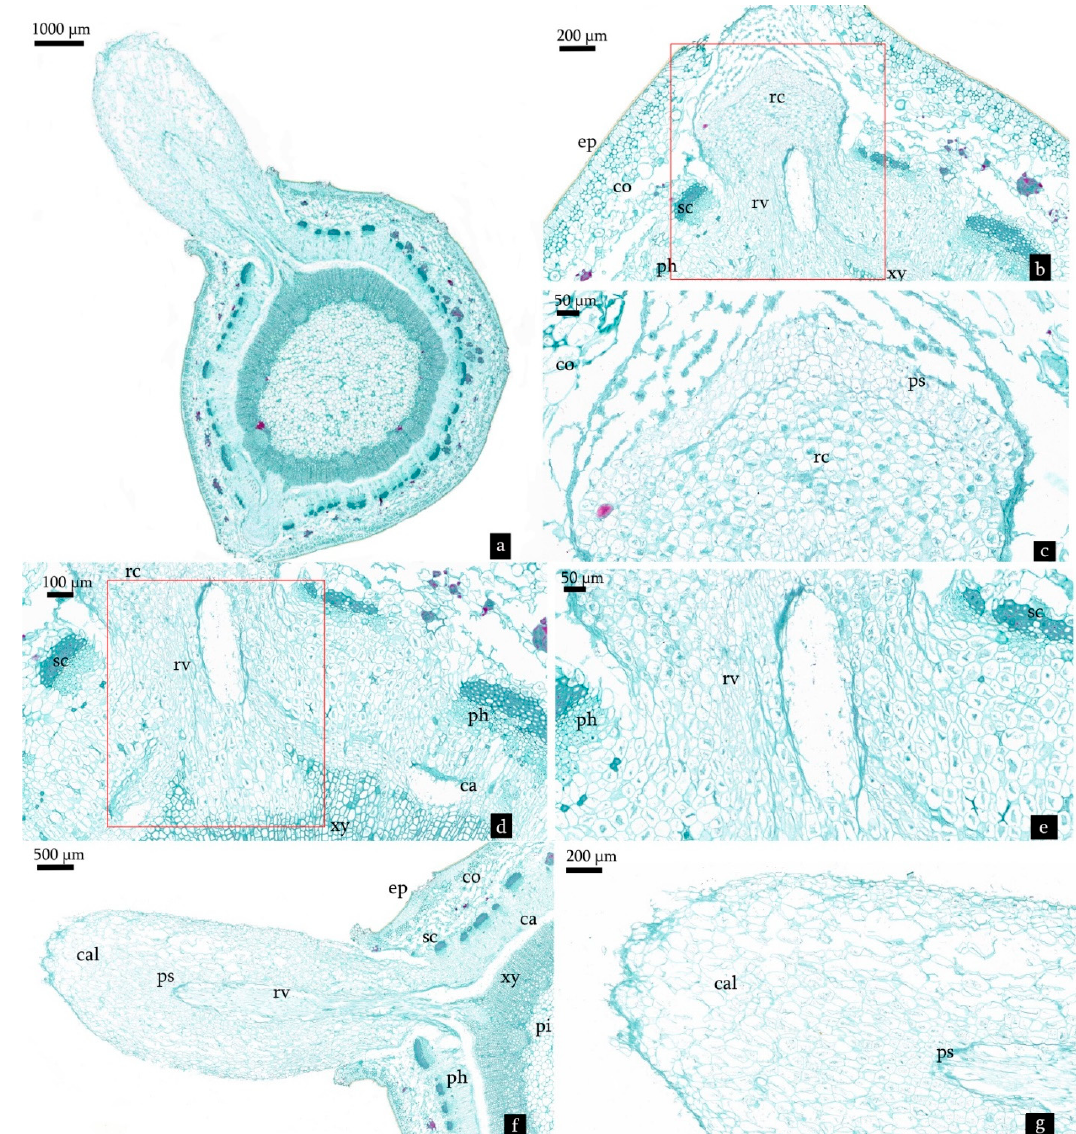
Figure 8. Transverse sections derived from cuttings treated with NAA:IBA (2:1) on the 28th day after planting. ( a ) Histological structure of cuttings treated with NAA:IBA (2:1) on the 28th day after planting. ( b ) Root primordia which achieved differentiation pushing into the cortex through the sclerenchyma of the cuttings. Red frame shows the adventitious root. ( c ) Root cap of the adventitious roots. ( d , e ) Root vascular bundles connected with the stem. Red frame shows the root vascular. ( f ) The adventitious root penetrated through cortex and callus tissue. ( g ) The callus tissue on epidermis functionally formed the root cap of adventitious roots. Abbreviations: ep = epidermis; co = cortex; sc = sclerenchyma; ph = phloem; ca = cambium; xy = xylem; prp = precursor of adventitious root primordia; cal = callus tissue; ps = procambium strand; pi = pith; rv = root vascular cylinder; rc = root